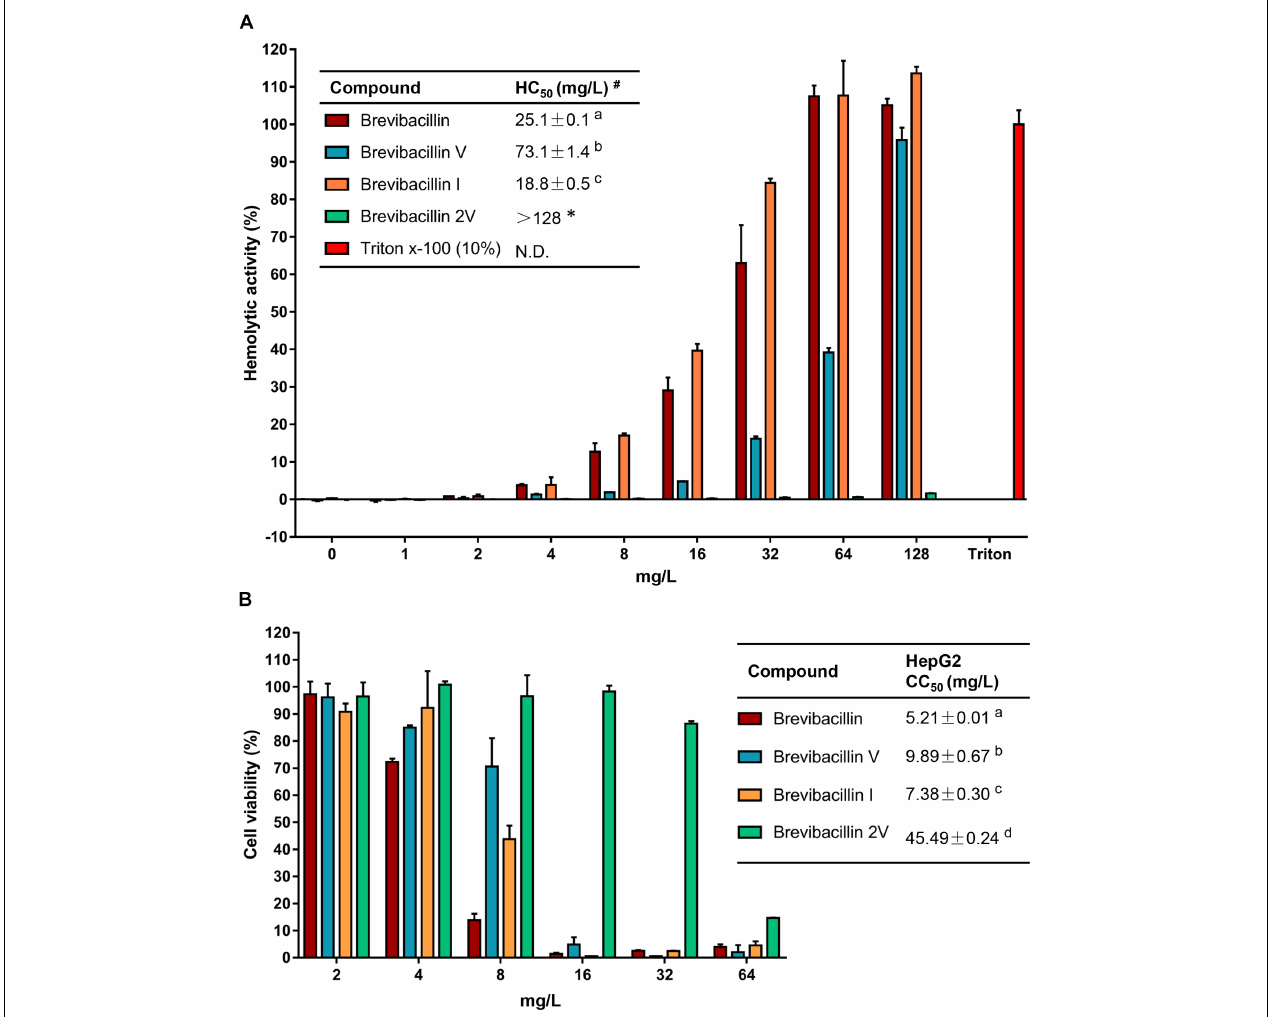
FIGURE 3 | Brevibacillins activities against eukaryotic cells. (A) Human erythrocytes were incubated with brevibacillins at concentrations ranging from 1 to 128 mg/L. Their hemolytic activity was assessed by the release of hemoglobin. Cells treated without a tested compound were used as no lysis control. Cells treated with 10% Triton X-100 were used as complete lysis control. The data are representative of three independent experiments. # HC 50 is the concentration that causes 50% hemolysis of human red blood cells. N.D., not determined. a , b , c Significant differences exist when not the same letters are indicated in the HC 50 column ( p < 0.05). *No hemolytic activity was observed for brevibacillin 2V at 128 mg/L and its HC 50 > 128 mg/L. (B) Cytotoxicity of brevibacillins against HepG2 cells. HepG2 cells were treated with brevibacillins at concentrations ranging from 2 to 64 mg/L. Cells treated without a tested compound were used as untreated control. After 24 h of treatment, cell viability was determined by an XTT kit. The data are representative of three independent experiments. a , b , c , d Significant differences exist when not the same letters are indicated in the CC 50 column ( p <